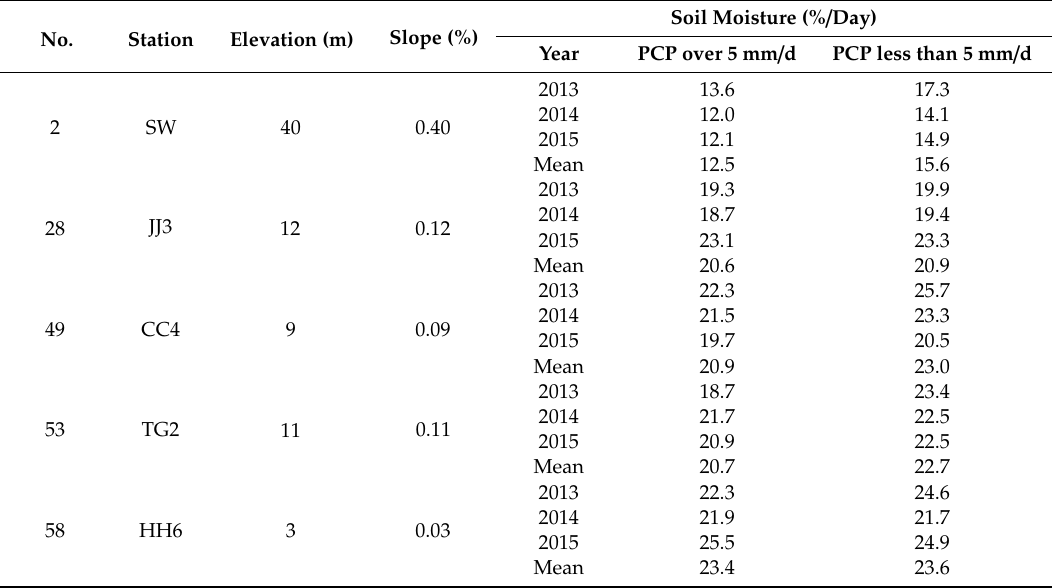
Table 5. The additional features to review limitation of this MQR result: elevation, slope, and seasonal SM.